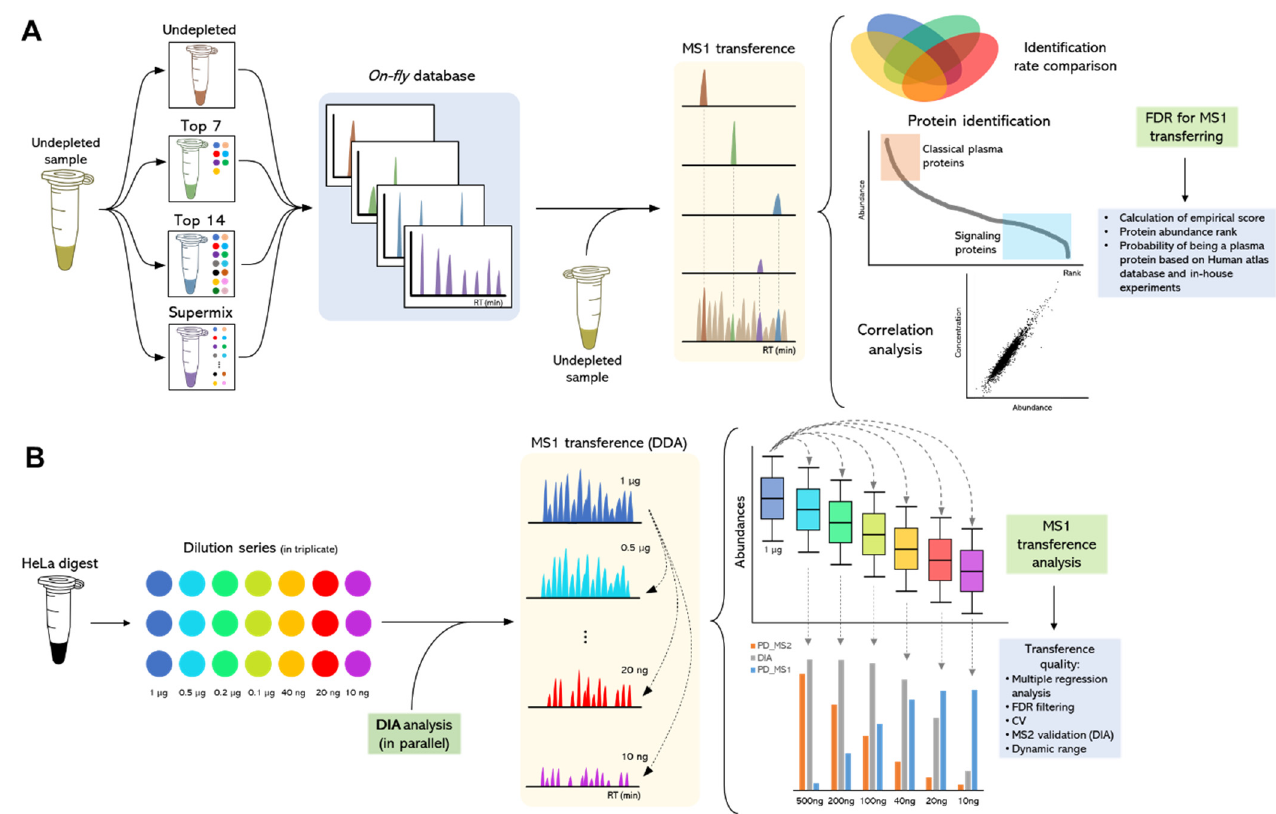
Figure 7. Experimental WiMT workflow for the assessment of low-abundance proteins in undepleted plasma samples. ( A ) The strategy used for the development of a custom database and its application for peptide identification using MS1t. ( B ) Experimental model design for the evaluation of MS1t strategy using a 6-time diluted commercial HeLa sample.